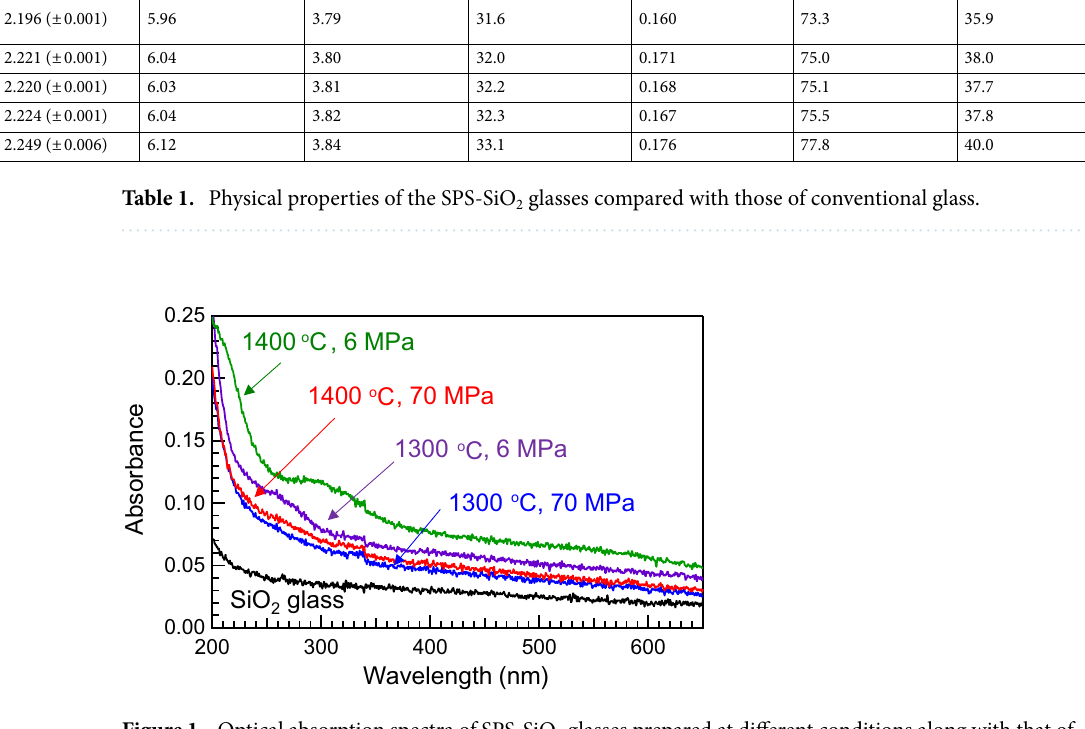
Figure 1. Optical absorption spectra of SPS-SiO 2 glasses prepared at different conditions along with that of SiO 2